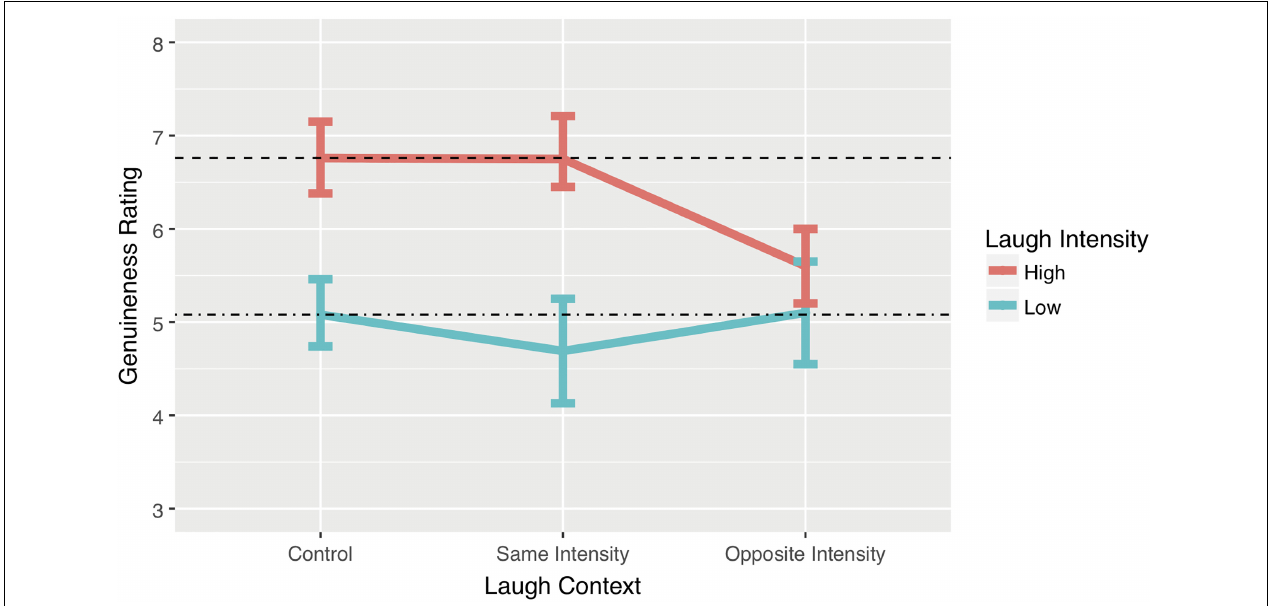
FIGURE 4 | Point estimates derived from the model for each of the conditions. Error bars represent 95% Confidence Intervals.